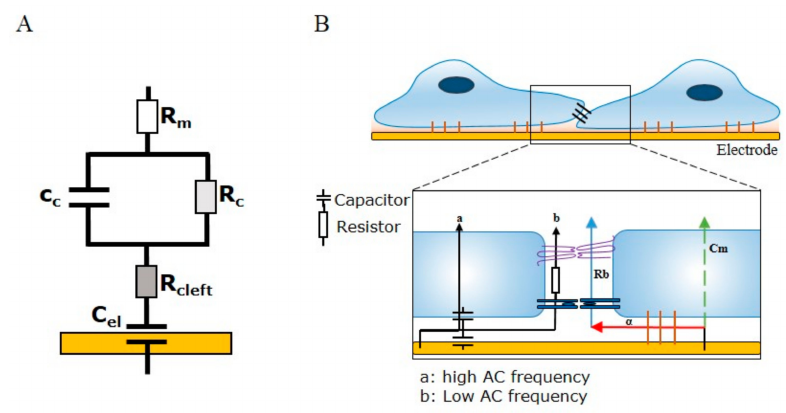
Figure 1. Schematic illustration demonstrating electrical cell-substrate impedance sensing (ECIS) current flow and modelled parameters. ( A ) An equivalent circuit demonstrating how the electrode, cell layer, and respective media compartments are connected within the ECIS model. Modelling for the paracellular barrier (R b ), basal adhesion ( α ), and cell membrane capacitance (C m ) integrate different components of the electrode capacitance (C el ), the basal cleft resistance (R cleft ), the cell capacitance and resistance (C c and R c , respectively), and the resistance of apical medium (R m ); ( B ) A schematic of endothelial cells grown on an ECIS electrode. Changes in cell–cell junctions and subcellular adhesion can be measured with ECIS as changes in the current flow at high (>10,000 Hz) and low (4000 Hz) frequencies. A high-frequency current passes through the cell body to couple the capacitive functions of the electrode and cell membrane. Low frequencies take the paracellular route and are resisted by intercellular junctions such as tight junctions and adherens junctions (measured as resistance). Analysis of confluent monolayer properties uses the modelled parameters R b, α , and C m. R b is dependent on the collective sum of the intercellular space and the tightness of cell–cell junctions, α is dependent on the cell radius and subcellular adhesion, and C m models changes in the composition of cell